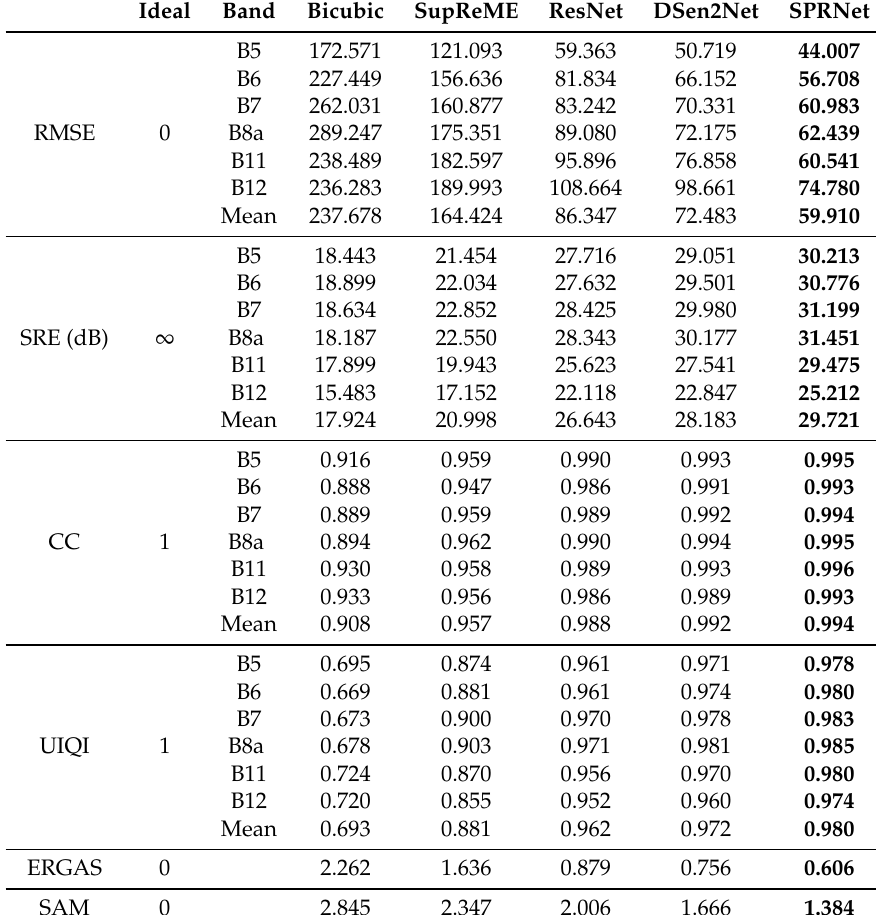
Table 2. Quantitative assessment of the SPRNet 2 Bold indicates the best